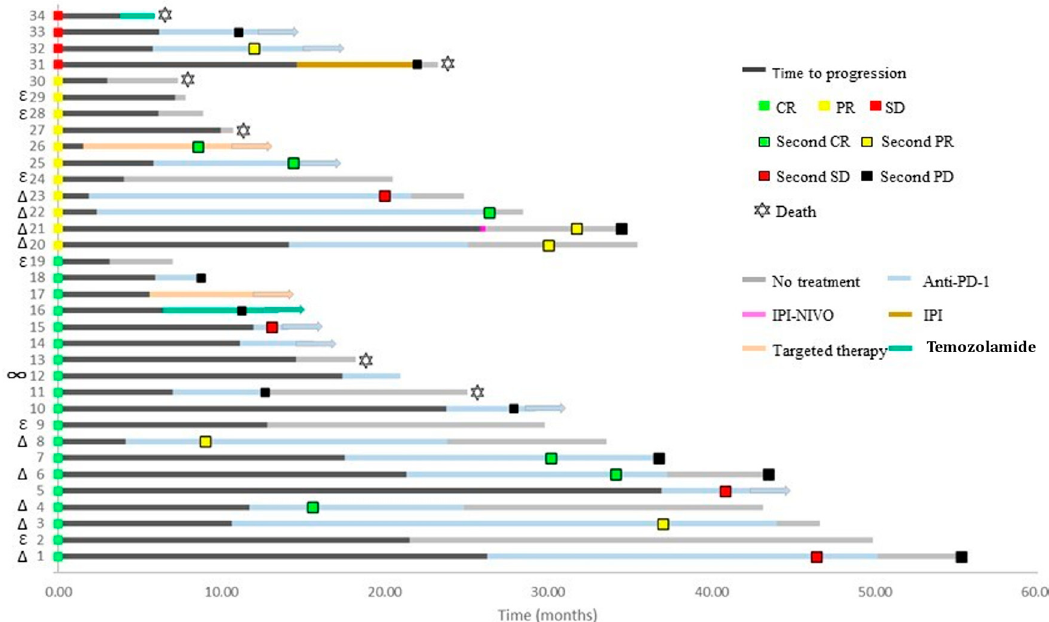
Figure 4. Individual clinical courses for patients with disease progression following treatment discontinuation. Data is presented from treatment discontinuation to last follow-up, second progression, or death. The best response to previous treatment is presented at the onset of the plot, followed by time to progression (time off-treatment), systemic re-treatment, and response. There was no significant correlation between time off-treatment and response to the subsequent treatment; median time off-treatment in patients who responded (PR/CR) to the subsequent treatment was 15 months, whereas for patients who maintained SD or developed PD, the median time to progression was 11.8 months ( p = 0.95). Δ In patients 1, 3, 4, 6, 8, and 20–23, re-treatment was discontinued due to treatment-limiting toxicity. ∞ Patient 12 was lost to follow-up after re-induction of anti-PD-1. ℇ Patients who were treated with local therapy: patients 2, 9, and 19 were treated with radiotherapy or surgery to subcutaneous and lung metastasis and are now free of disease; patients 24 and 29 had soft-tissue progression, which was treated with radiotherapy, and are currently planned to start systemic treatment; patient 28 had brain progression treated with SRS and achieved near-CR. Abbreviations: SRS—stereotactic radiosurgery; CR—com-